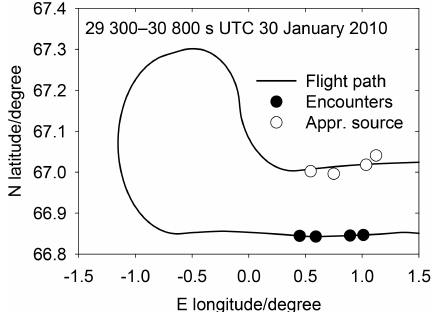
Figure A1. Geophysica flight path during RECONCILE with ex- haust plume encounters in two periods between the pairs of black circles and the corresponding approximate source positions (white circles) computed for measured wind and best-fitting plume